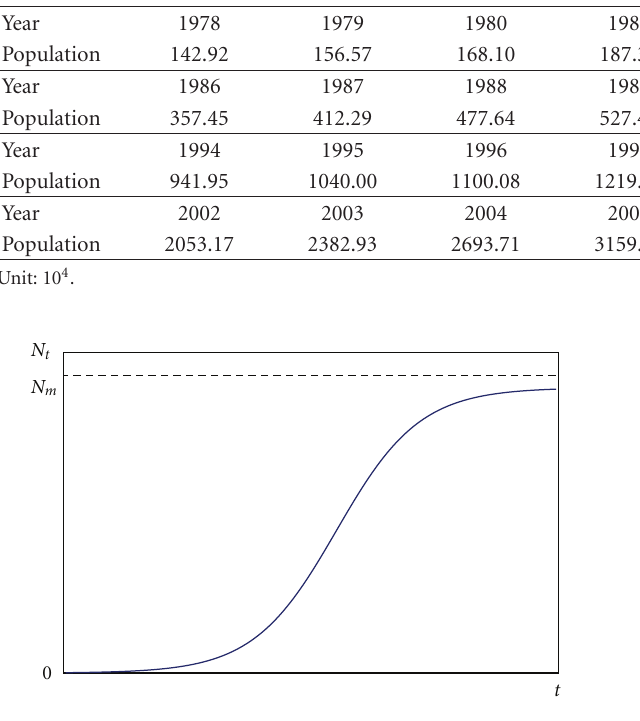
Figure 1: Logistic model curve.